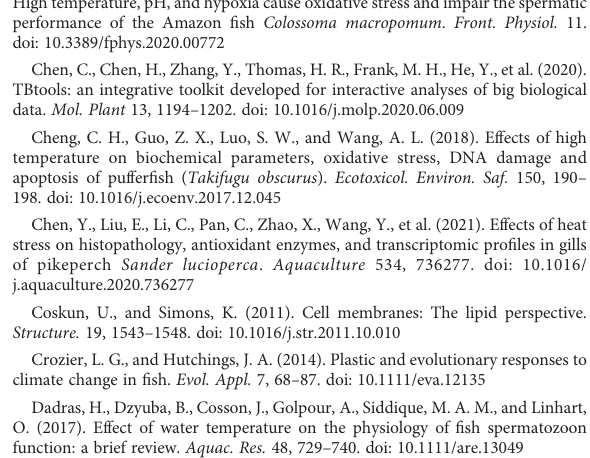
between the 19°C and 10°C groups. SUPPLEMENTARY TABLE 5 The differential lipids in the liver among four temperature groups. SUPPLEMENTARY TABLE 6 The differential lipids of each cluster identi fi ed by k-means analysis. SUPPLEMENTARY FIGURE 1 Signi fi cantly differentially expressed genes. (A) The shared differentially expressed genes of 4 tissues between the 19°C and 10°C groups. (B) Signi fi cantly differentially expressed genes involved in energy metabolism and immune response. SUPPLEMENTARY FIGURE 2 Comparisons between RNA-seq and qPCR results. SUPPLEMENTARY FIGURE 3 Expression patterns of genes identi fi ed by STEM analysis. SUPPLEMENTARY FIGURE 4 Score scatter plot of the OPLS-DA